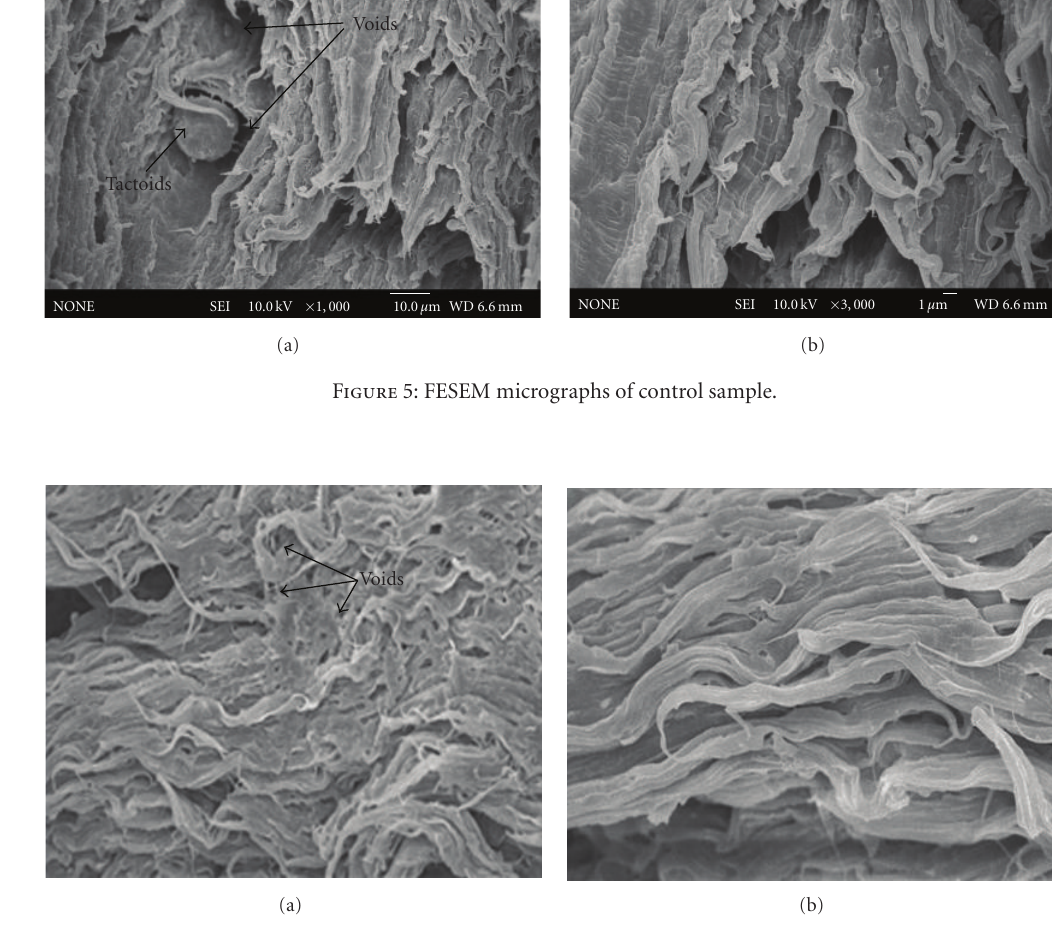
Figure 6: FESEM micrographs of EB-irradiated